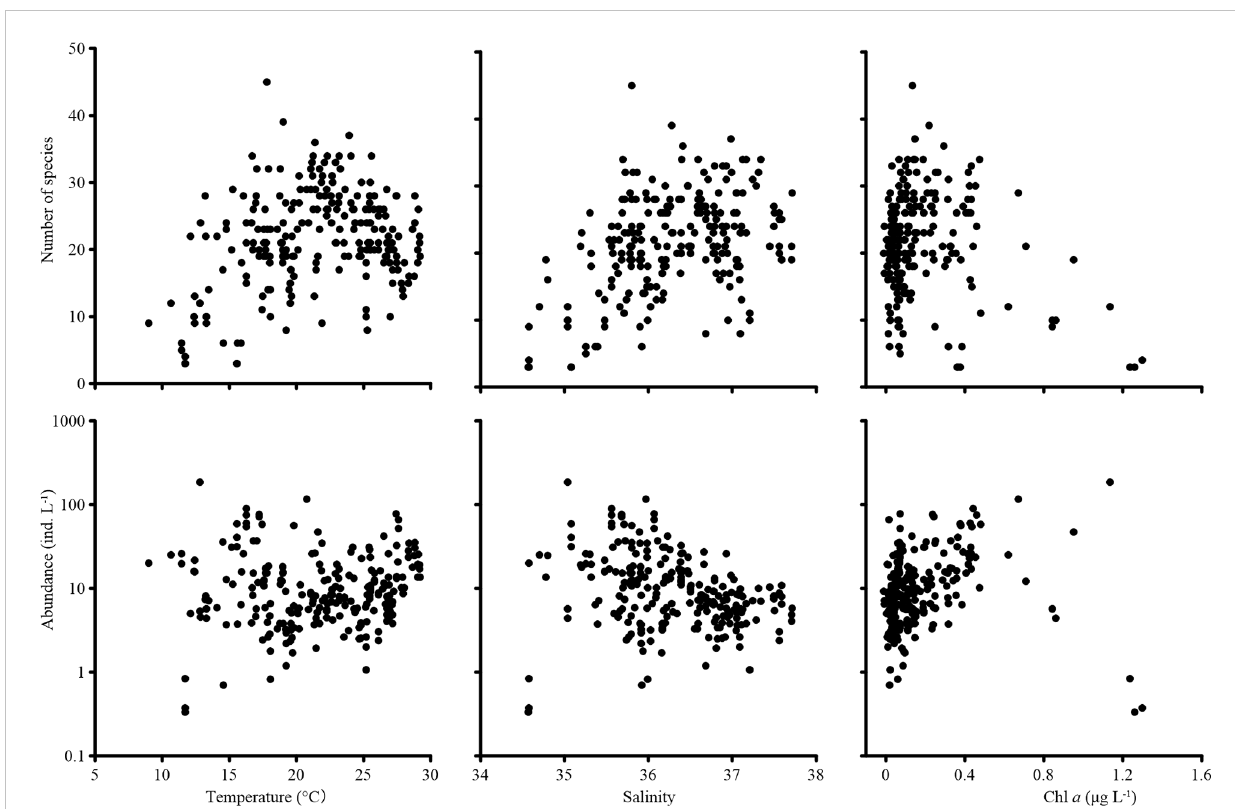
FIGURE 8 Tintinnina species richness and abundance variation with temperature, salinity, and in vivo chlorophyll a fl uorescence (Chl a ).